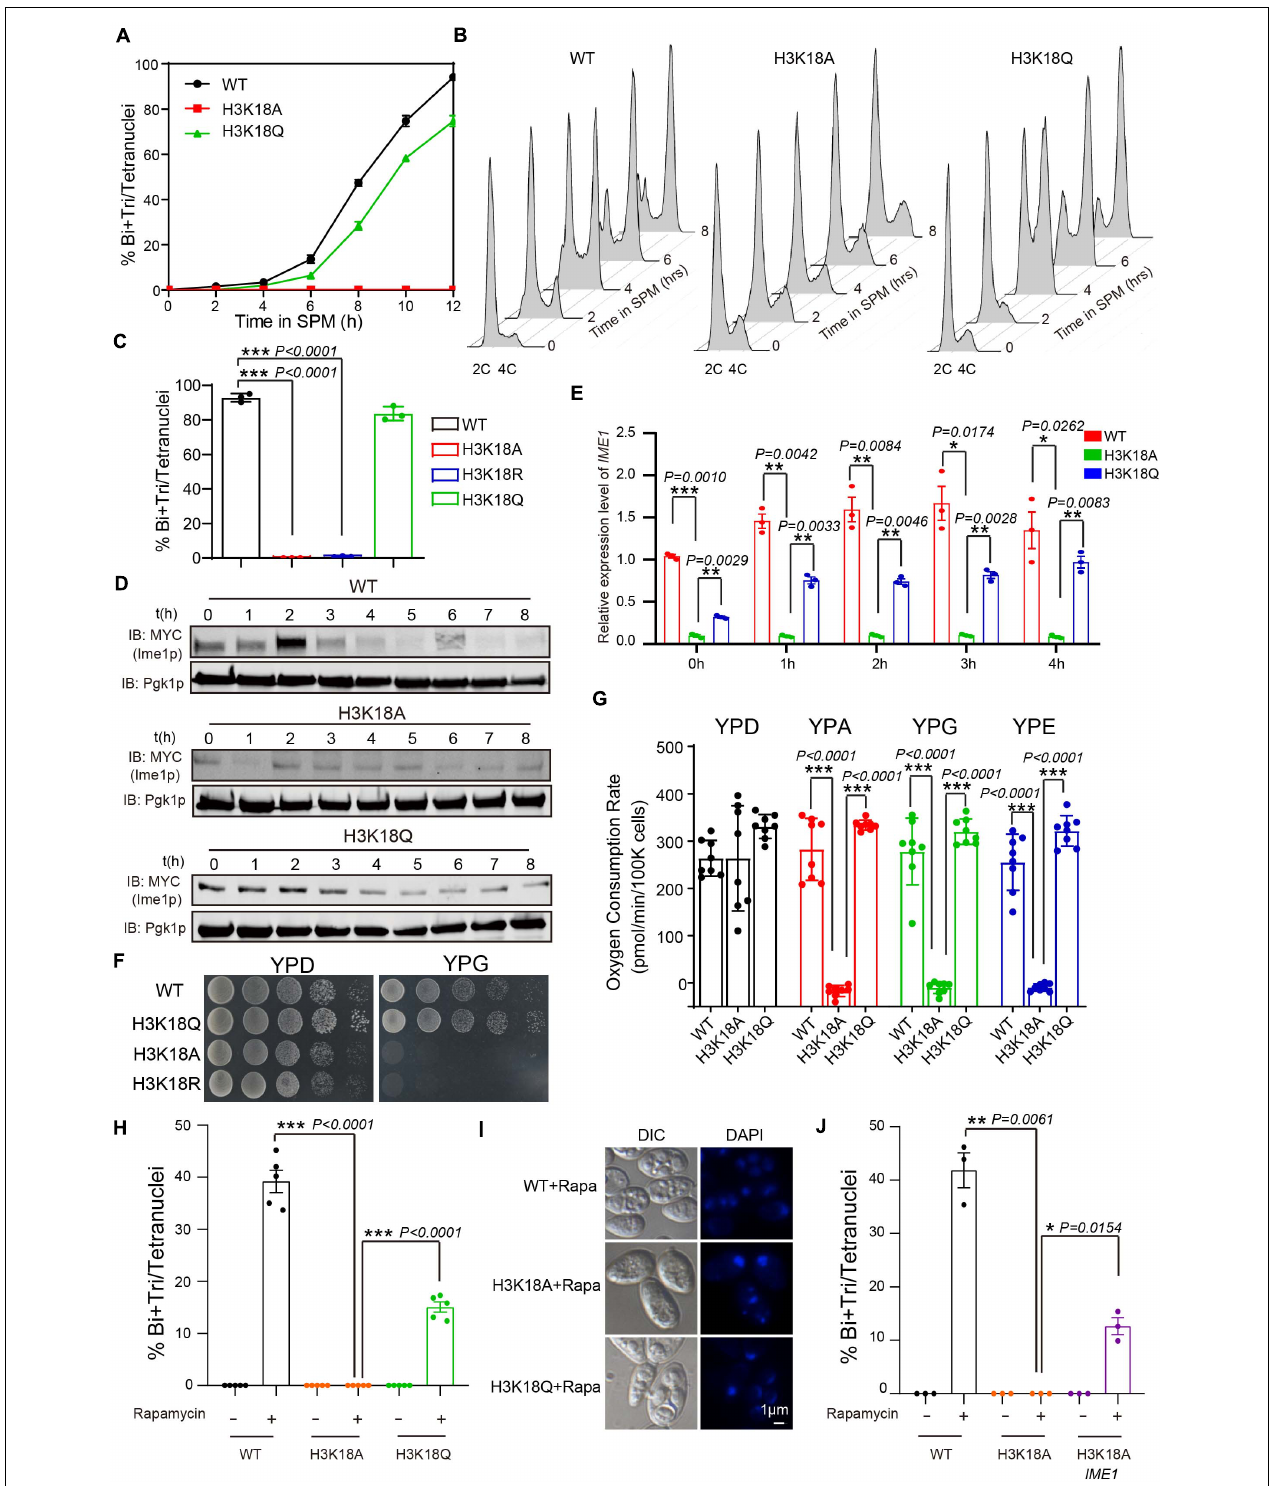
FIGURE 4 | Persistent H3K18ac state is sufficient to induce yeast sporulation. (A) Sporulation curve of WT, H3K18A and H3K18Q mutant strains in SPM from 0 h to 12 h. 300 µ L samples were fixed with 1 mL 70% ethanol for at least 1 h and then stained with DAPI to calculate sporulation rates. The error bars indicate ± SD ( n = 3). (B) Flow cytometry of the WT, H3K18A, and H3K18Q mutant strains. Samples were prepared at different times after being cultured in SPM to detect premeiotic DNA replication (2C-4C transition). Premeiotic DNA replication was blocked in the H3K18A mutant strain, whereas the H3K18Q mutant strain